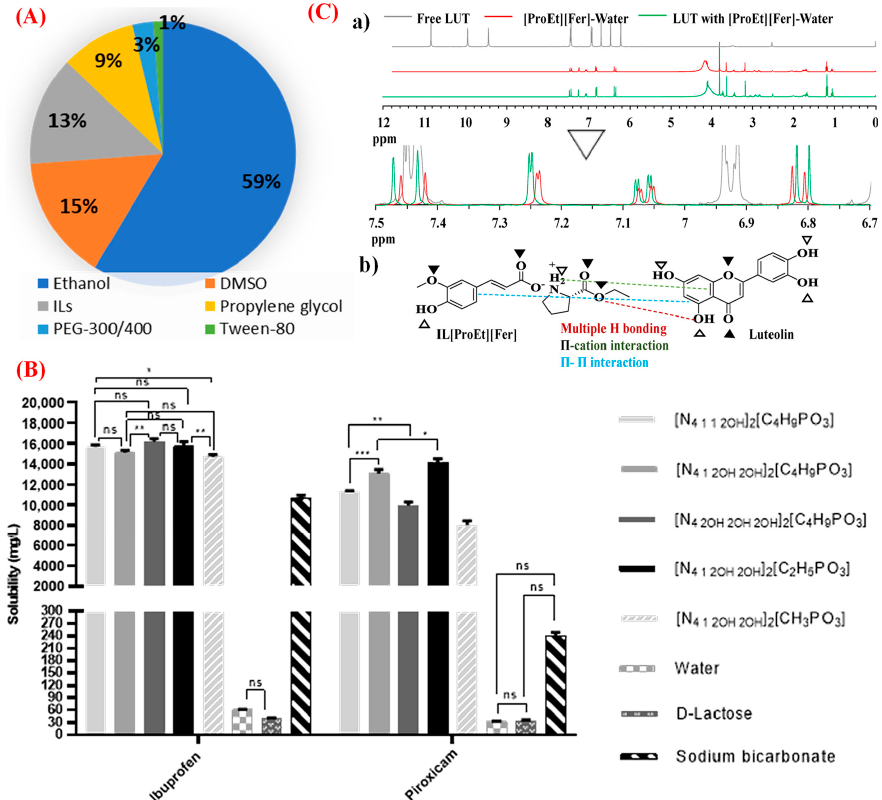
Figure 3. ( A ) A comparison of the use of ILs with commonly used pharmaceutical solvents/co-sol- vents and surfactants/co-surfactants [39]; ( B ) solubility of ibuprofen and piroxicam with ILs—com- monly used excipients and water. Statistical significant differences are represented in asterisks: *** p < 0.0001, Ibuprofen: ** p = 0.0013 or p = 0.0085 and * p = 0.0119; Piroxicam: *** p = 0.0005, ** p = 0.0032 and * p = 0.0102, and ns—non-significant.[34]; ( C ) Overlapped proton NMR spectra of IL-luteolin complexes ( a ); and the schematic diagram of the interactions between luteolin (Lut) and proline ethyl ester ferulate (IL[ProEt][Fer]) ( b ) [31], reproduced with permission from